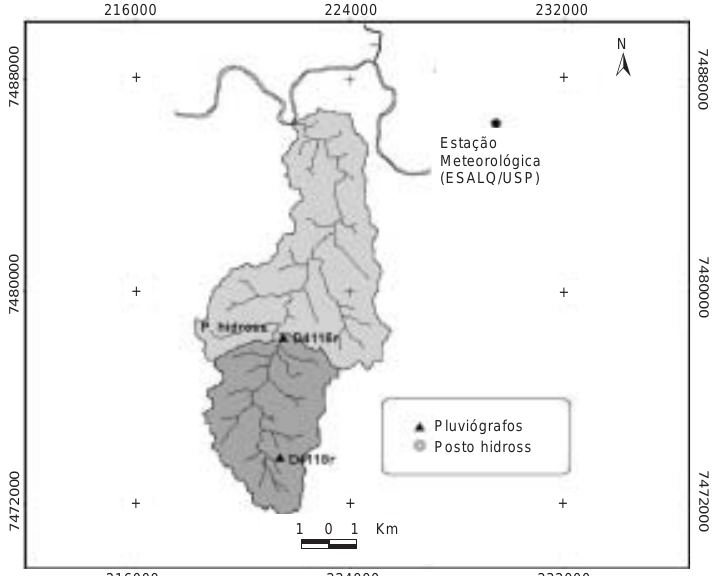
Figura 1. Microbacia do Ribeirão dos Marins, com a indicação da localização do posto hidrossedimentométrico e dos